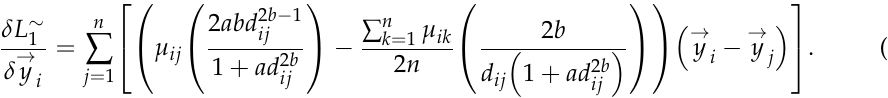
Figure 4. The dependency of curve (6) shape on the 𝑑 (cid:3040)(cid:3036)(cid:3041) parameter value.